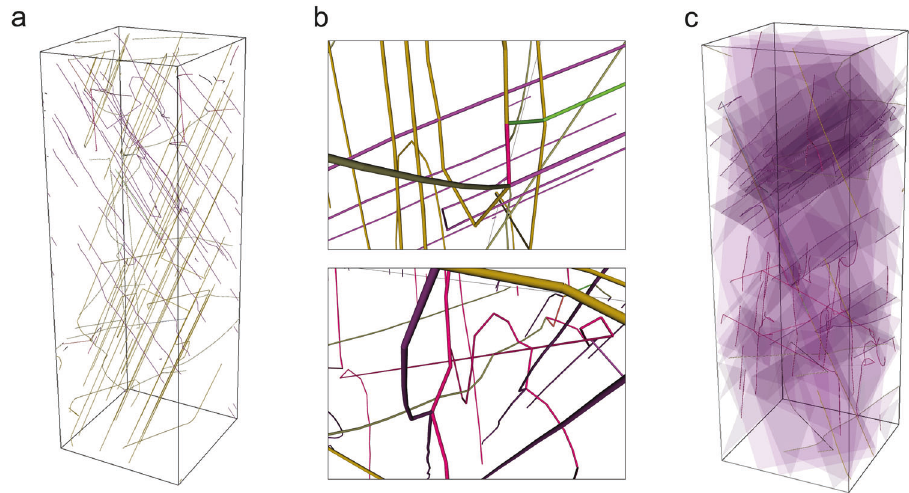
Fig. 8 Examples of discrete dislocation dynamics simulation box. a Entire microcrystal after deforming to ε = 0.3. b Examples of dislocation networks, triple junctions, and pileups occurring throughout the simulated volume. c Slip systems highlighted for